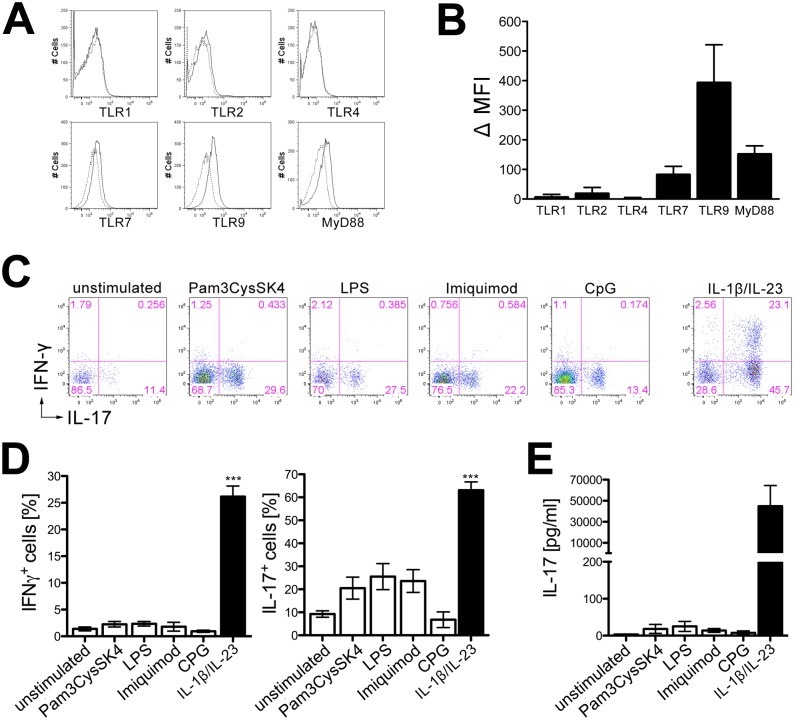
Naïve γδ T cells express TLRs but do not secrete IL-17 in response to TLR stimulation.
(A, B) γδ T cells were isolated from C57BL/6J mice and stained at their cell surface (TLR1, TLR2, TLR4) or intracellularly (TLR7, TLR9, MyD88) with antibodies directed against the indicated TLR (solid line) and the respective isotype control (dotted line). Data are displayed as delta (Δ) mean fluorescence intensity (MFI) of the specific antibody in relation to the isotype control ± SEM from 3 to 5 individual experiments. (C, D) γδ T cells were isolated from C57BL/6J mice and stimulated with the TLR ligands Pam3CysSK4 (100 ng/ml), LPS (100 ng/ml), imiquimod (10 μg/ml), CpG (1 μM), or IL-1β and IL-23 (10 ng/ml each). Unstimulated cells served as a negative control. After 3 days, cells were re-stimulated and analyzed by flow cytometry for intracellular IFN-γ and IL-17 expression. Results in (D) are shown as mean ± SEM of 3 experiments, ANOVA with Dunnett´s multiple comparison post test of each ligand vs. unstimulated control. (E) γδ T cells were stimulated as described in (C), but supernatants were collected directly after 3 days and analyzed by IL-17 ELISA. Results are shown as mean ± SEM of 3 individual experiments, ANOVA with Dunnett´s multiple comparison post test of each ligand vs. unstimulated control, (D) p = 0.3262, p = 0.0355, (E) p = 0.4647.